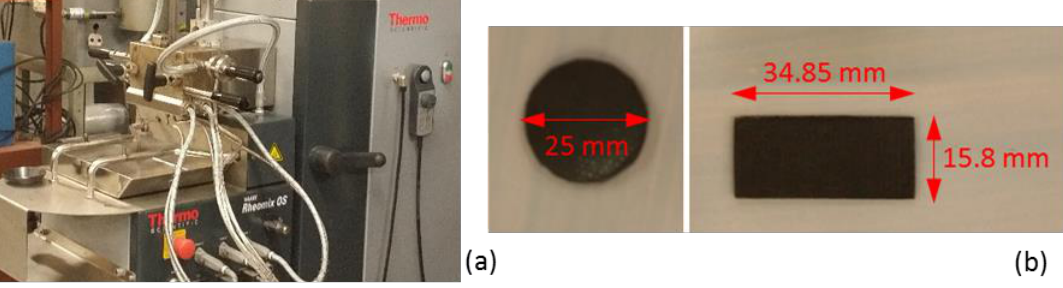
Figure 1. ( a ) Haake mixer, and ( b ) rheology circular sample and C-band EMI shielding rectangular sample.